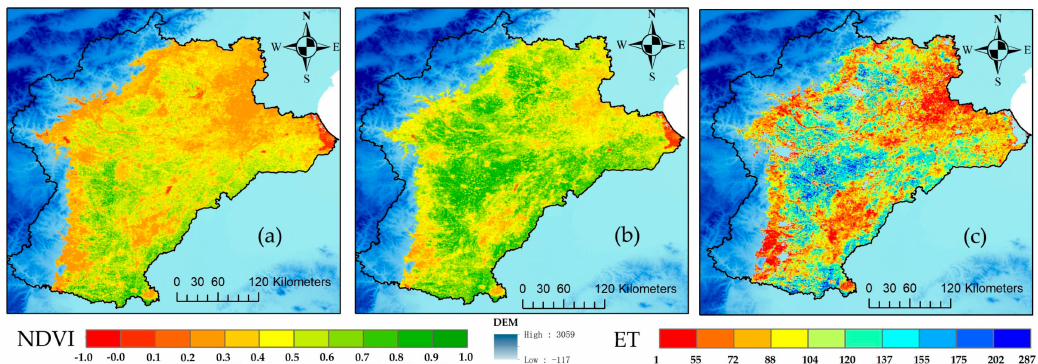
Figure 8. Sample selection based on MODIS NDVI and ET: ( a ) MODIS NDVI of DOY (day of year)